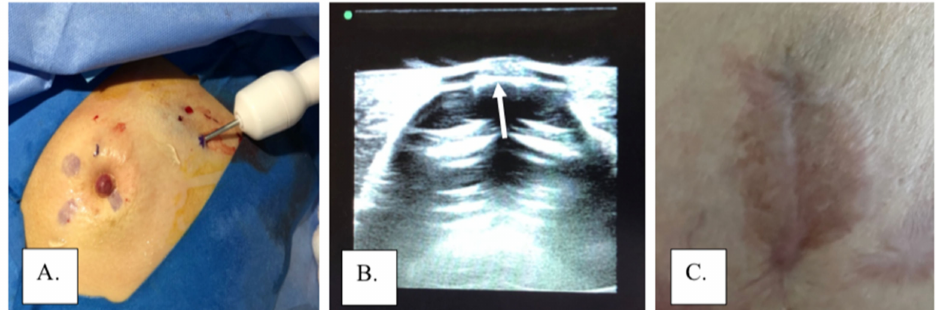
Figure 5. Cryoablation of subareolar lesion with local excision of excision: ( A ) cryoprobe during ablation of a subareolar lesion, ( B ) ice ball extending to the base of the nipple (arrow) viewed through a gel standoff pad, and ( C ) areola following excision of nipple under local